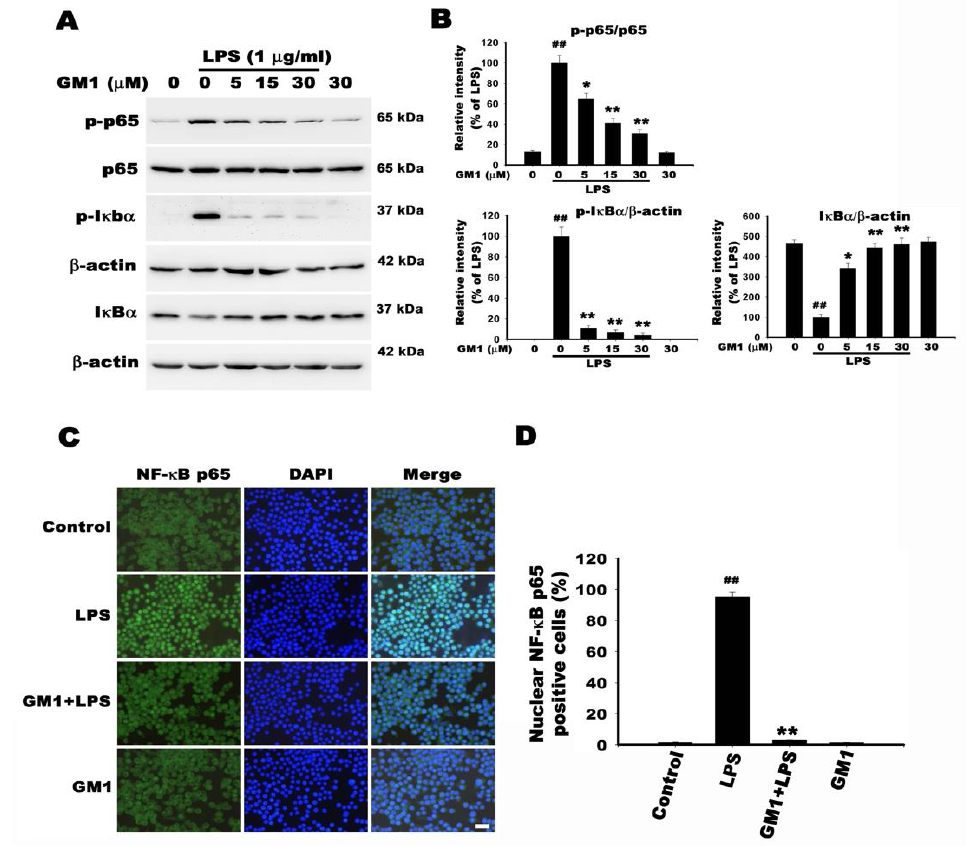
Figure 8. Effect of GM1 on NF- κB activation in LPS -stimulated RAW 264.7 cells. ( A ) Cells